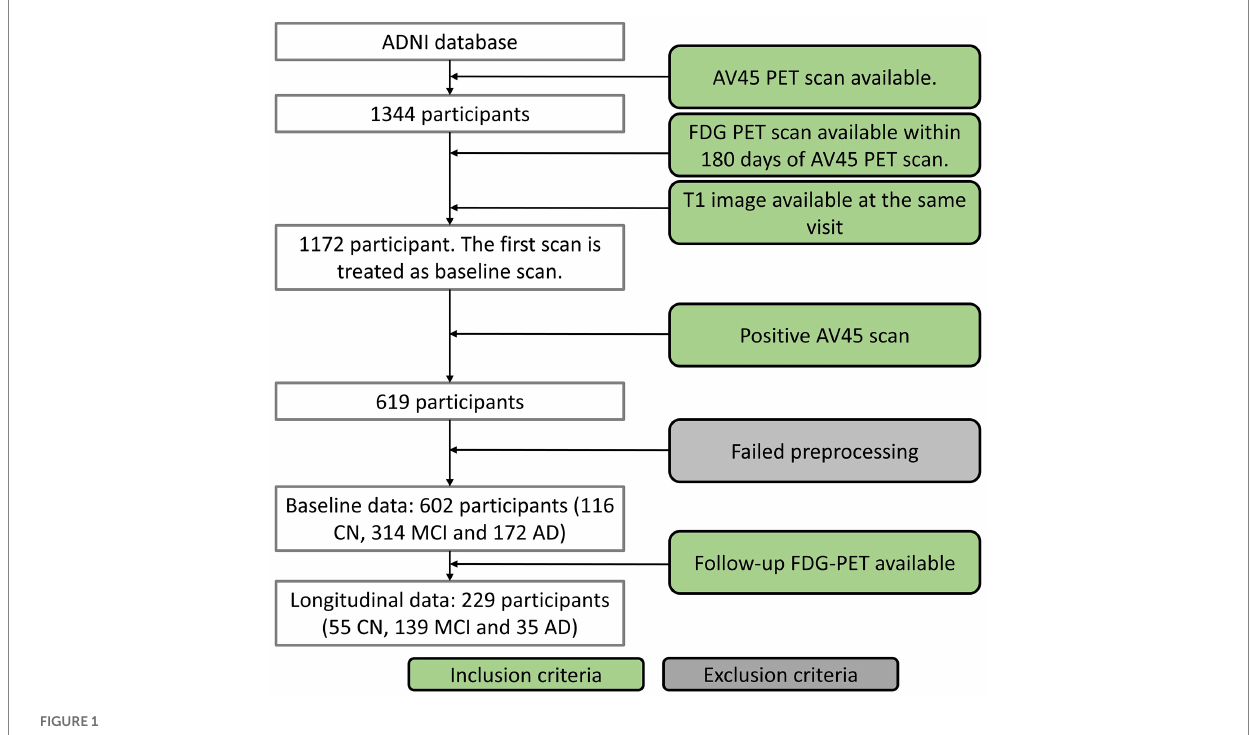
FIGURE 1 Participant inclusion